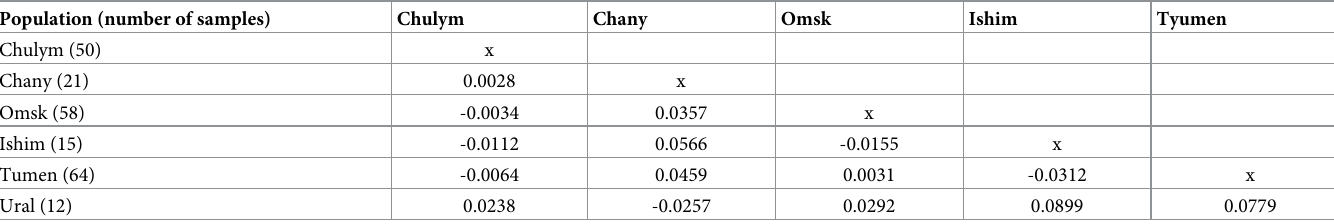
Table 4. Pairwise F st distance between populations of L . dispar